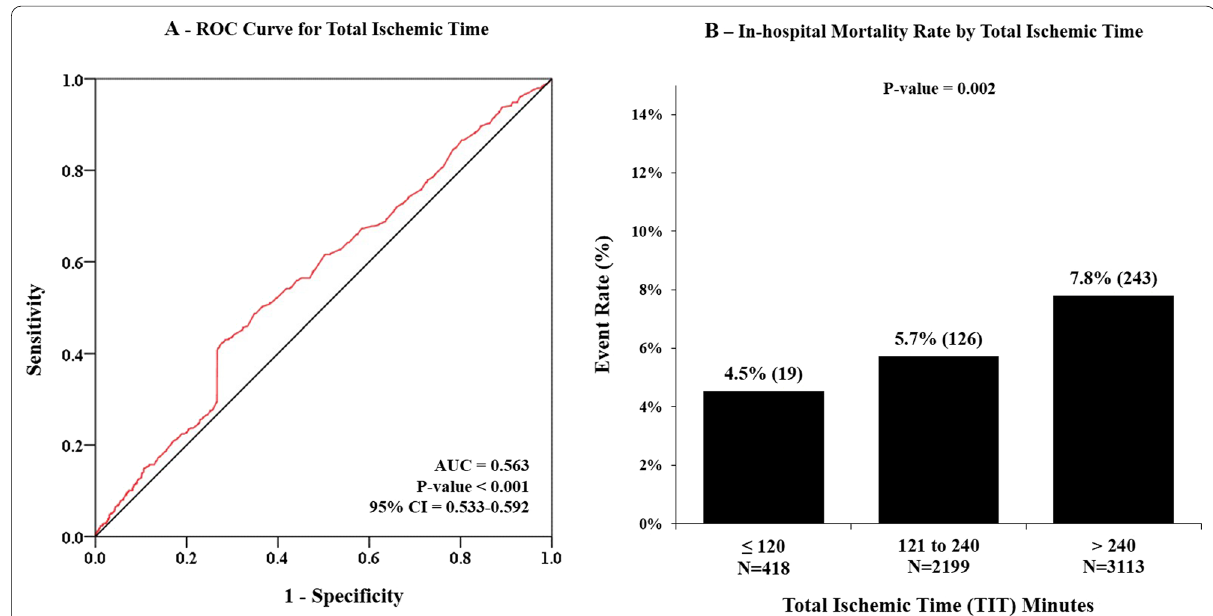
Fig. 1 A Receiver operating characteristic (ROC) curve and B in-hospital mortality rate stratified by the total ischemic time